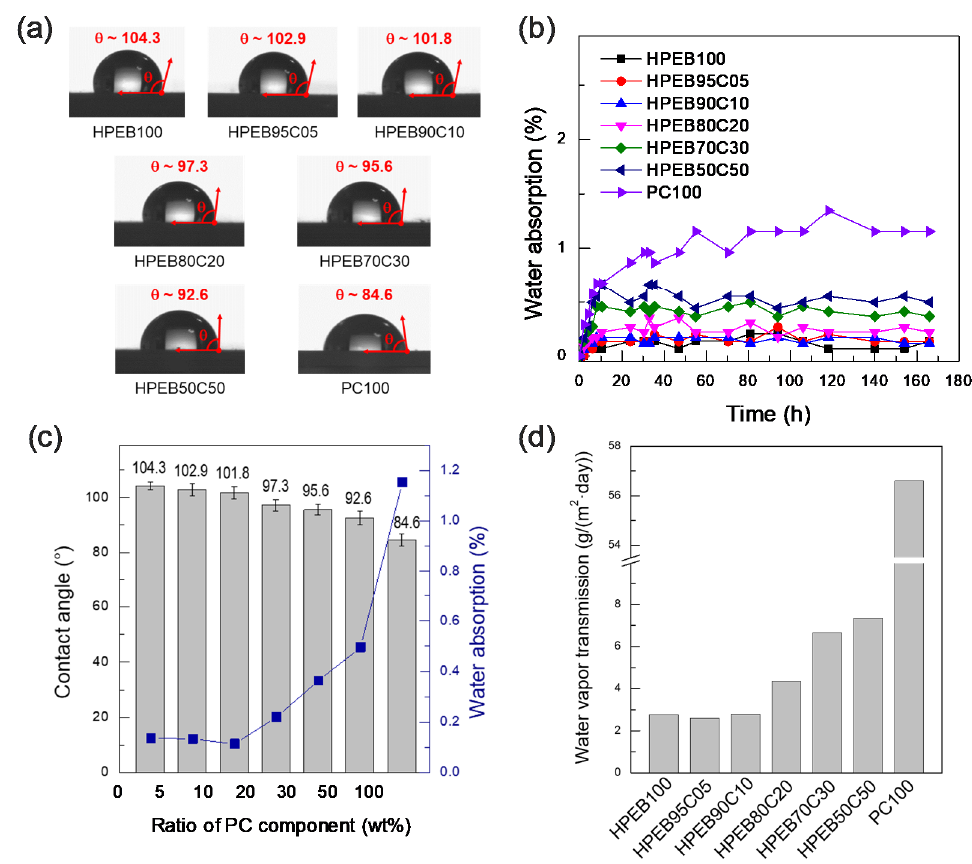
Figure 4. ( a ) Water contact angle images of the polyurethane copolymers, ( b ) water absorption plots of the polyurethane copolymers as a function of time, ( c ) relationship graph between the water contact angle values and the water absorption of the polyurethane copolymers as a function of the amount of PC component and ( d ) water vapor transmission values of the polyurethane copolymers.